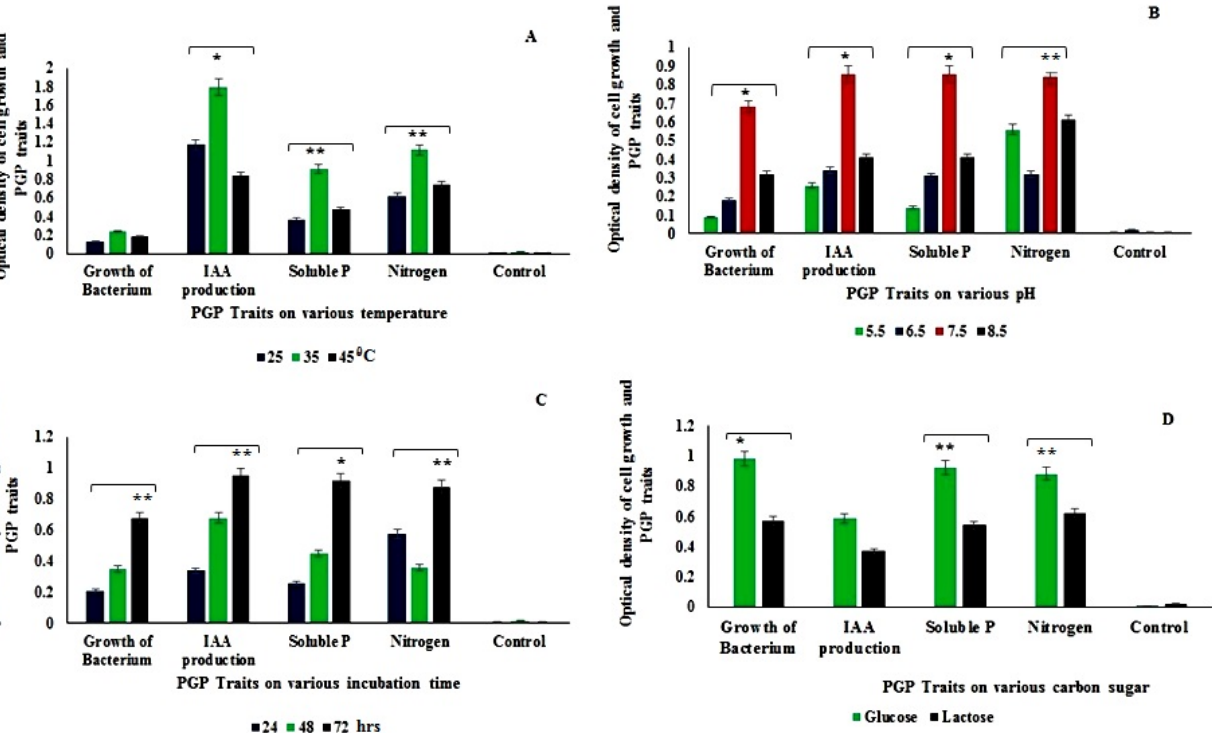
Figure 3. Optimization of growth parameters for IAA, nitrogen fixation, and phosphate solubilization by Kosakonia sp. MGR1. The obtained values are the mean and standard error ( ± SE) of triplicates. ( A ) Optimal temperature for IAA, nitrogen production, and soluble P; ( B ) optimal pH for IAA, nitrogen production, and soluble P; ( C ) optimal hours of incubation for IAA, nitrogen production, and soluble P; ( D ) optimal sugar for IAA, nitrogen production, and soluble P. The values were significantly different at p < 0.003 * and p < 0.005 ** with relevant parameters. Mohite [12] determined various ranges of pH (5–9) and temperature (20–40 ◦ C) for IAA (25 µ g · mL − 1 ) production and P solubilization (38 µ g · mL − 1 ) [34] by various Rhizobac- teria and found that slightly alkaline pH 8 and 30 ◦ C could enhance the IAA synthesis and phosphate solubilization. Sudha et al. [26] reported 37 ◦ C to be optimum for Rhizobium and Bacillus sp. for IAA production (pH 7.2) and 30 ◦ C and pH 7.0 to be optimum for Streptomyces sp. [14]. Under optimized conditions, the growth kinetics of Kosakonia sp. MGR1 for 48 h showed the maximum quantity of IAA (96.35 ± 3.45 µ g · mL − 1 ), nitrogen (89.6 ± 5.61 µ g · mL − 1 ), and soluble P (99.21 ± 5.24 µ g · mL − 1 ). An increased time of incuba- tion stabilized the growth of Kosakonia sp. MGR1 (Figure 4) but decreased the